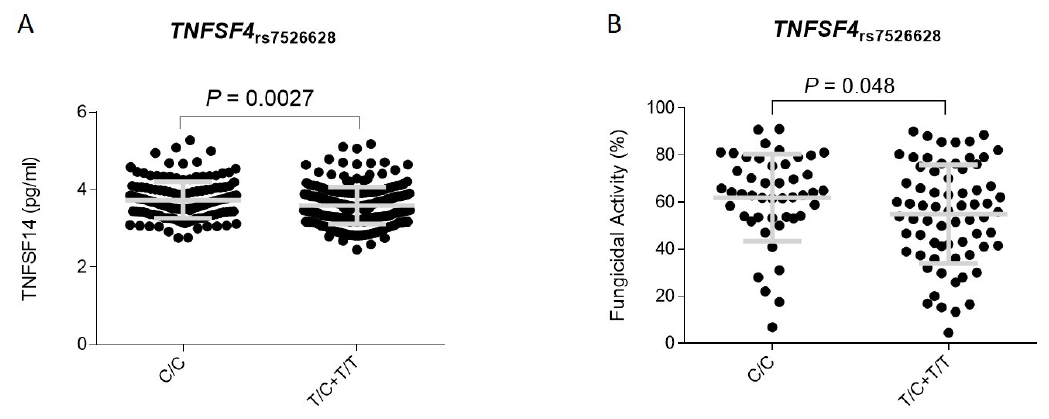
Figure 1. Correlation between the TNFSF4 rs7526628 SNP and serum levels of TNFSF14 (pg/mL) ( A ) and fungicidal activity (%) of monocyte-derived macrophages ( B ). Grey line represents the mean with error bars (standard deviation). Table 2. Association analysis of selected SNPs within the TNFSF4 and MAPKAPK2 loci and IA risk in the discovery cohort.